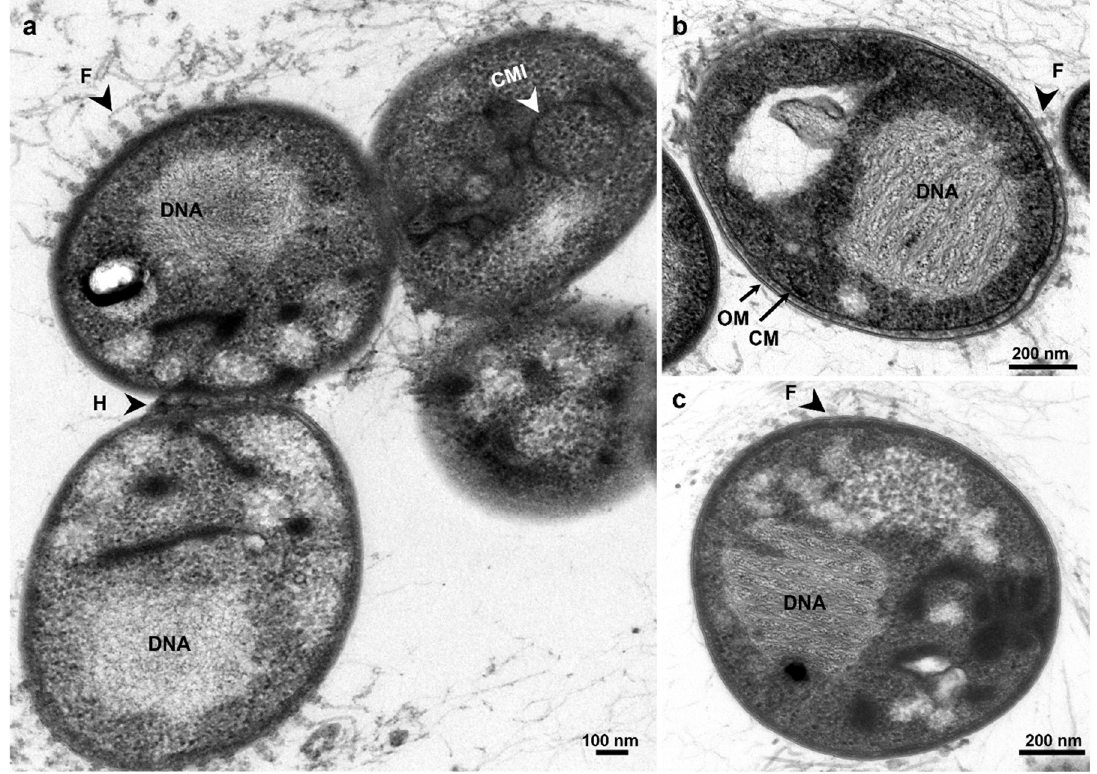
Figure 5. Micrographs from transmission electron microscopy observations showing the cell plan of strain ICT_E10.1 T in aggregated ( a ) and individual cells ( b , c ). A strong extracellular material is of strain ICT_E10.1 T in aggregated ( a ) and individual cells ( b , c ) . A strong extracellular material is seen connecting the cells ( a ). F: fimbriae, H: holdfast, CMI: cytoplasmatic membrane invaginations, seen connecting the cells (a). F: fimbriae, H: holdfast, CMI: cytoplasmatic membrane invaginations, CM: cytoplasmatic membrane, OM: outer membrane. CM: cytoplasmatic membrane, OM: outer